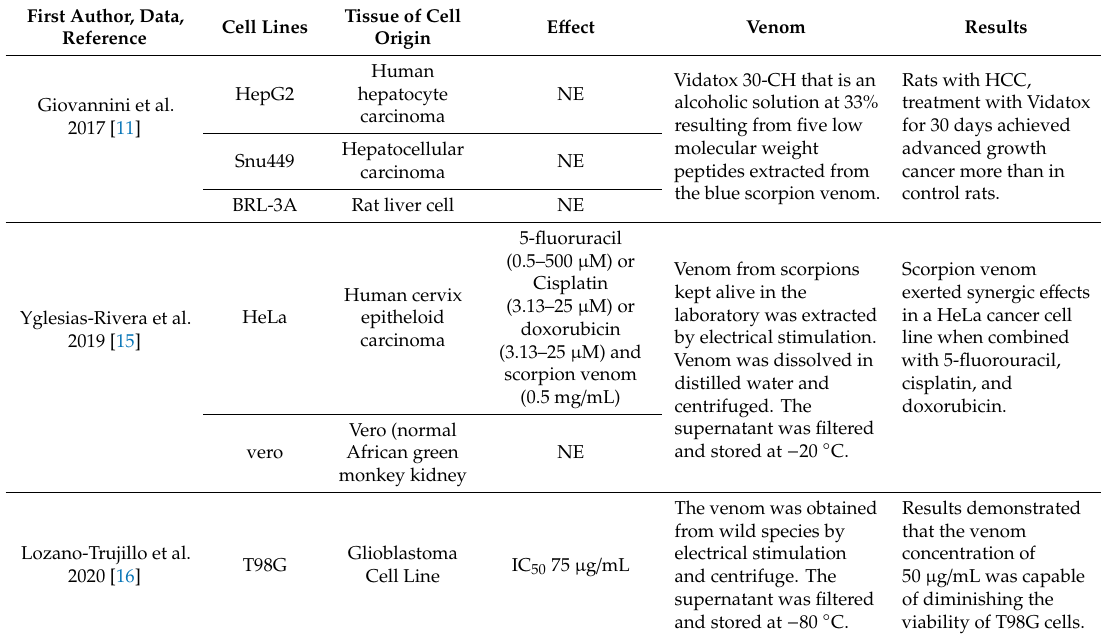
Table 3. The data extracted from articles not included in the meta-analysis (NE = no e ff